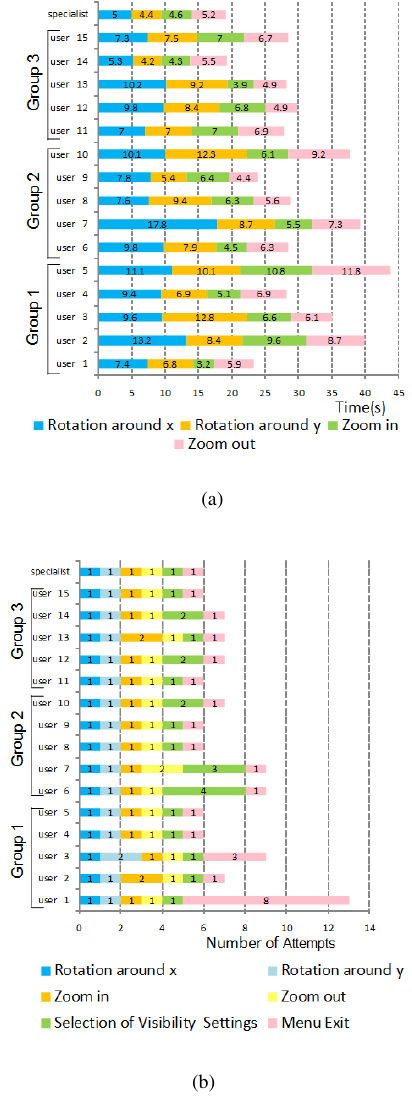
Fig. 15: In (a) and (b), the time spent and number of attempts to perform different tasks, when interacting with 3D models,